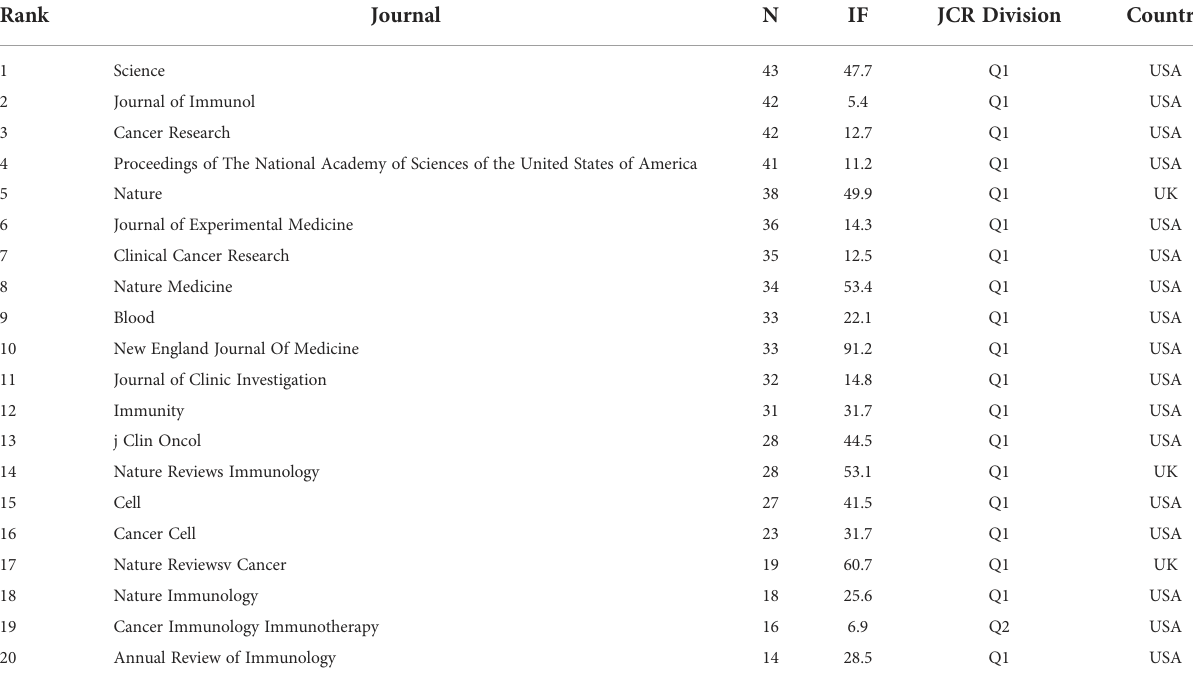
TABLE 8 The top co-cited 20 journals of top100 cited articles